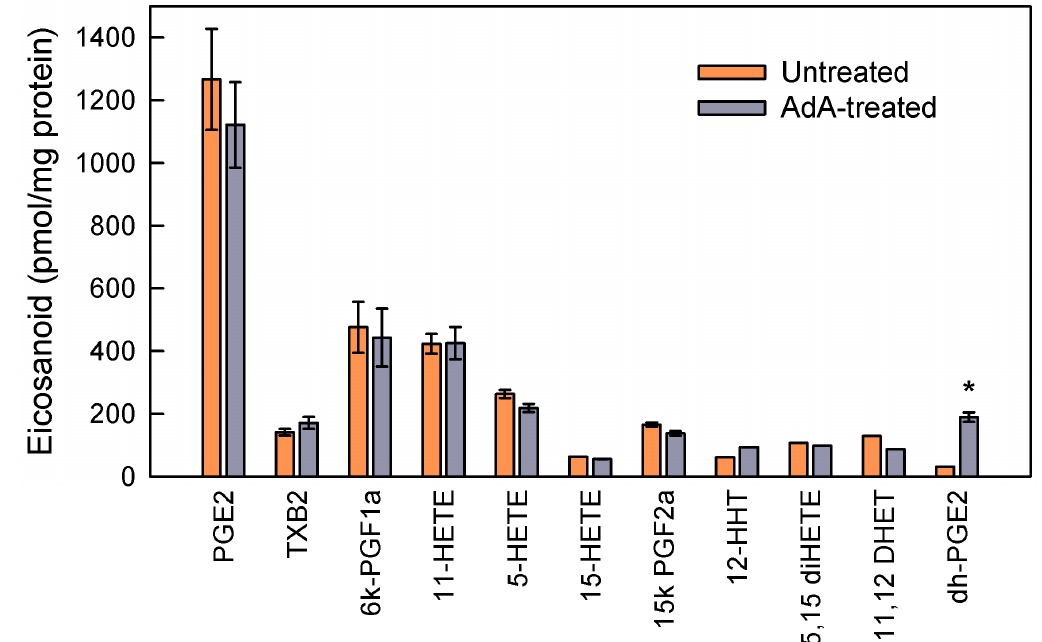
Figure 7. Eicosanoid production by stimulated macrophages. The cells were either untreated (orange bars) or treated with exogenous AdA for 20 h (gray bars). Afterward, the cells were stimulated by 1 mg/mL zymosan for 1 h, and eicosanoid content in the supernatants was analyzed by LC/MS. The data are expressed as mean values ± standard error of the mean of three individual replicates. Note: * p < 0.05, significantly different from incubations in the absence of AdA treatment. PGE2,